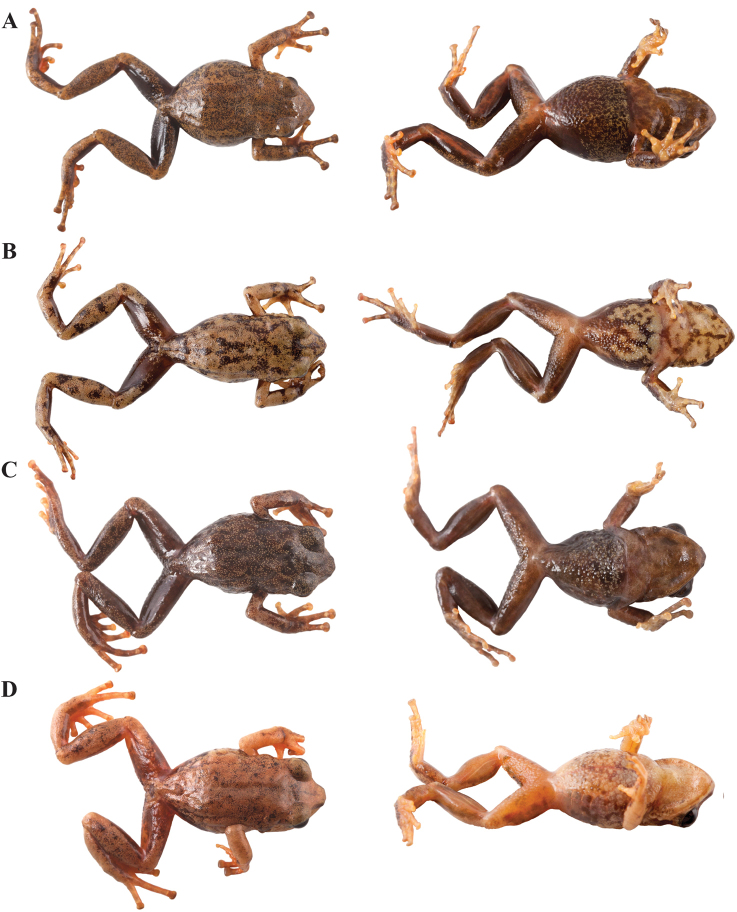
Color variation in live individuals of Pristimantis
chomskyi sp. nov. AQCAZ 47515 (holotype, male, SVL 24.0 mm) BQCAZ 45669 (juvenile male, SVL 21.4 mm) CQCAZ 45665 (juvenile female, SVL 19.7 mm) DQCAZ 45666 (juvenile female, SVL 21.9 mm). Dorsal view on the left, ventral view on the right.